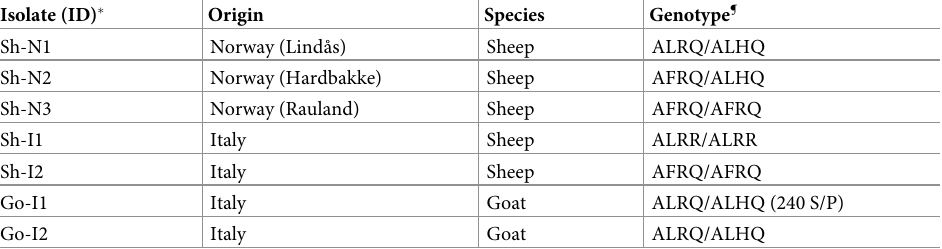
Table 1. Characteristics of natural atypical scrapie isolates used in the transmission studies. Isolate (ID) � Origin Species Genotype ¶ Sh-N1 Norway (Lind å s) Sheep ALRQ/ALHQ Sh-N2 Norway (Hardbakke) Sheep AFRQ/ALHQ Sh-N3 Norway (Rauland) Sheep AFRQ/AFRQ Sh-I1 Italy Sheep ALRR/ALRR Sh-I2 Italy Sheep AFRQ/AFRQ Go-I1 Italy Goat ALRQ/ALHQ (240 S/P) Go-I2 Italy